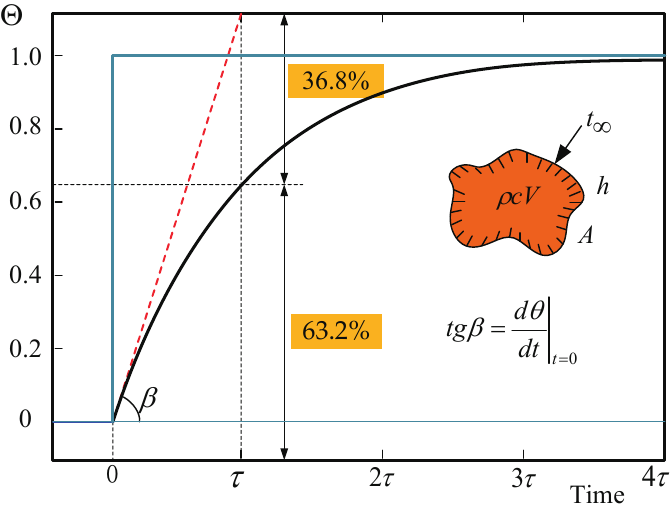
Figure 5. Dimensionless excess temperature of the object changes with